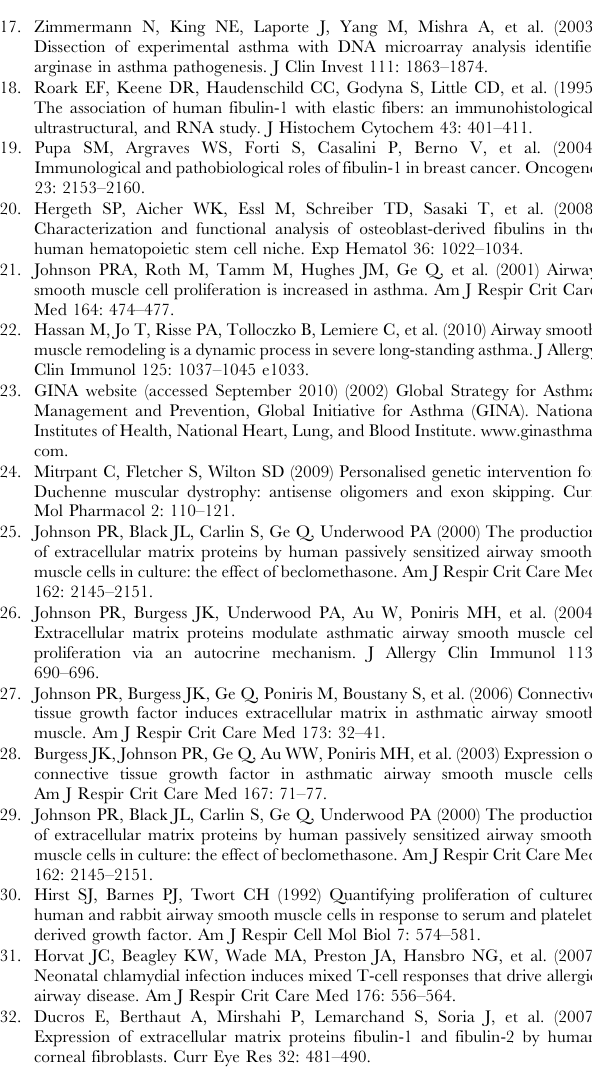
Table S1 Patient demographics. Diagnosis, sample type, age, gender and predicted forced expiratory volume in one second (FEV 1 ) of volunteers used in